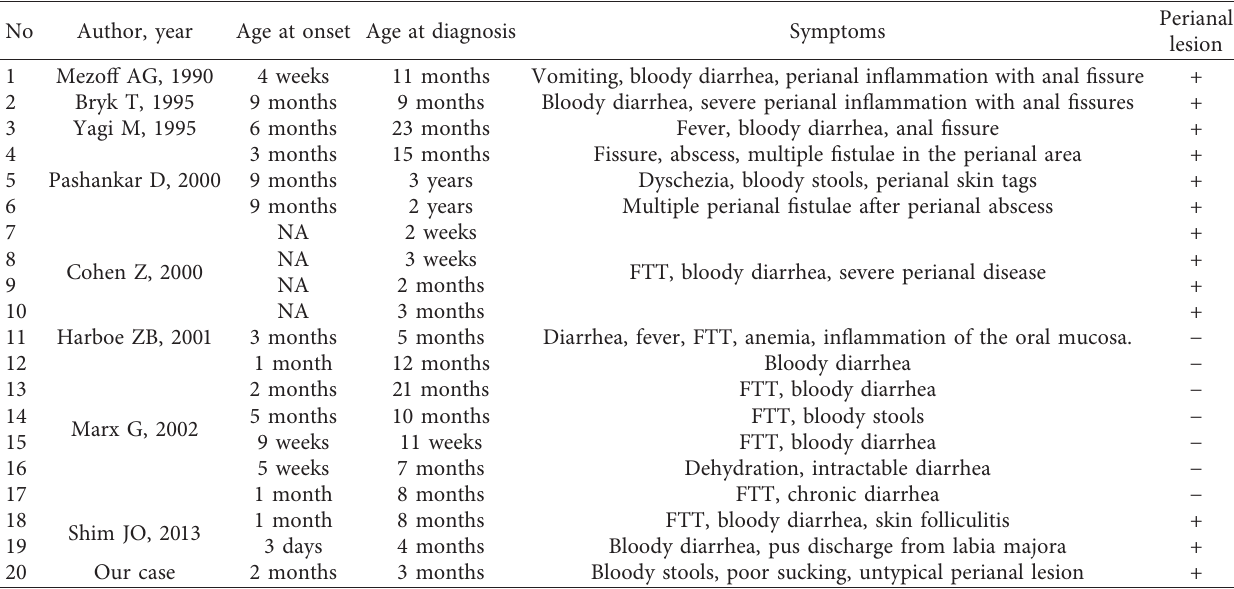
Table 1: A review of the literature concerning infantile CD, including our case.